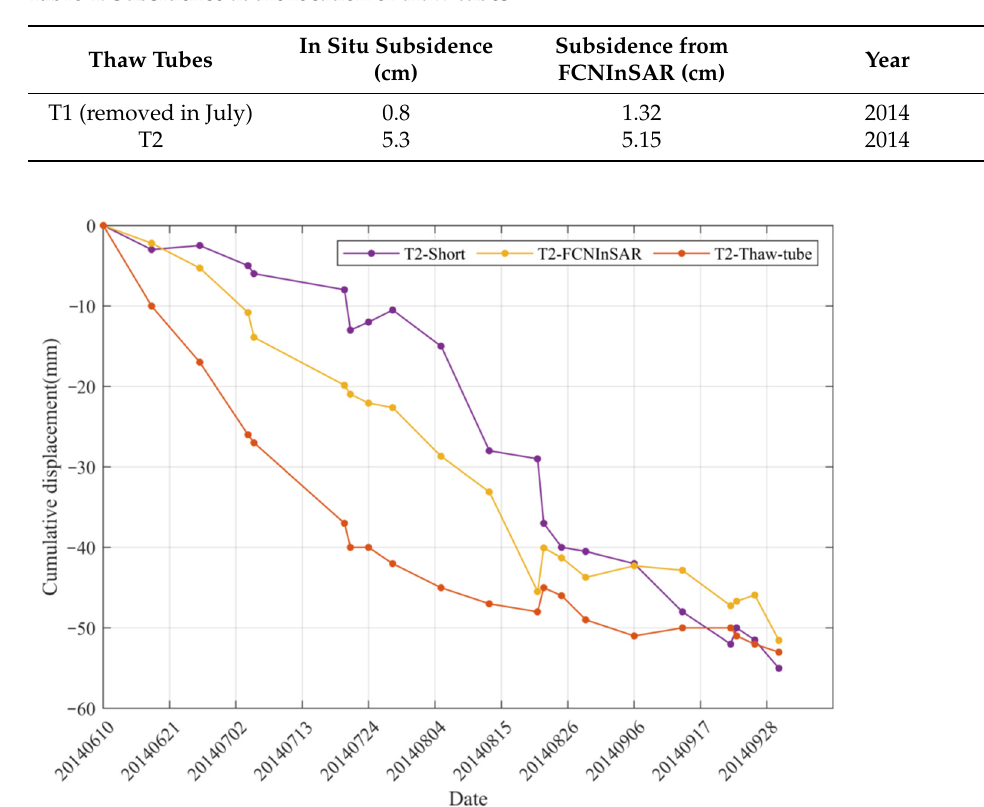
Figure 8. Ground displacement at T2 from Short et al. (2017), in situ measurement and FCNInSAR. Table 4. Subsidence at the location of thaw tubes.